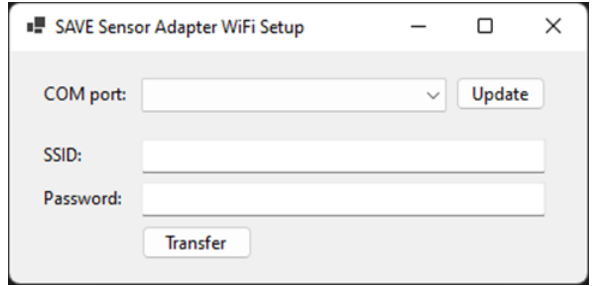
Figure 4. SAVE sensors adapter.